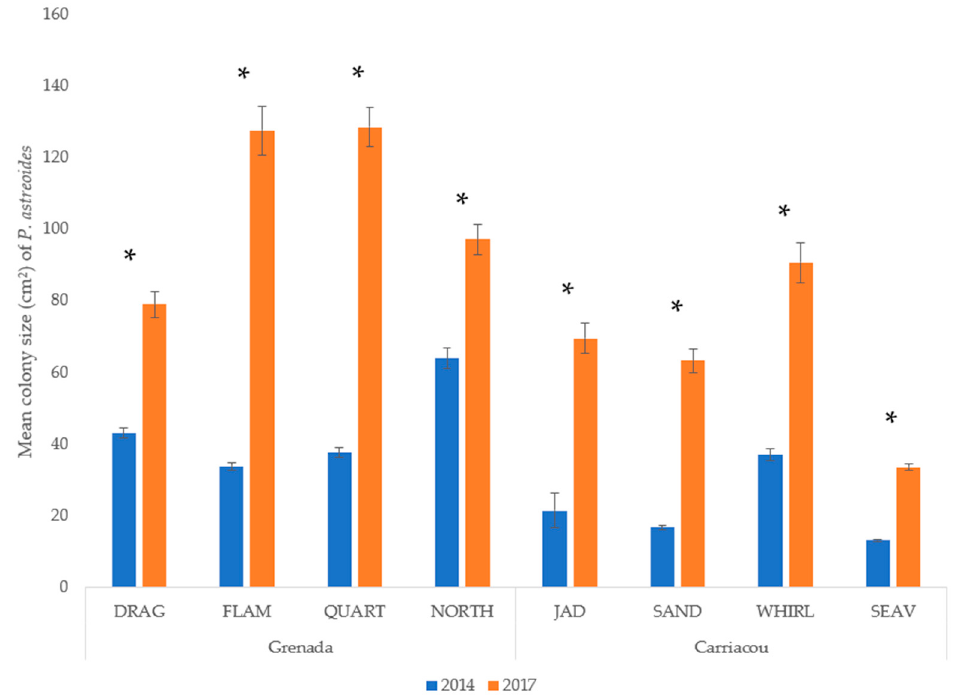
Figure 4. Mean colony size (cm 2 ) of P. astreoides in 2014 and 2017 in Carriacou and Grenada. (*) denotes significance ( p < 0.05) between years.